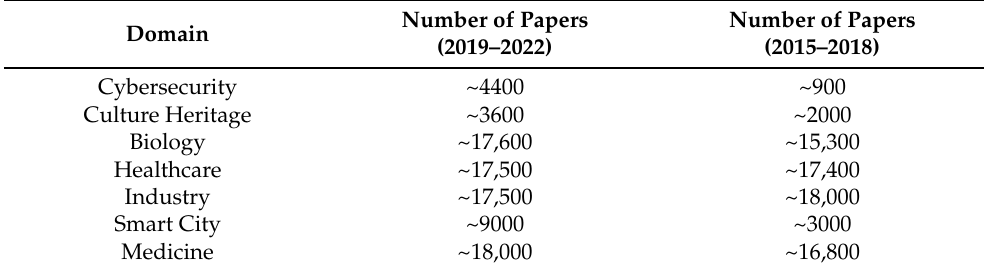
Table 2. Number of KG applications per domain from 2019 to 2022, and from 2015 to 2018.